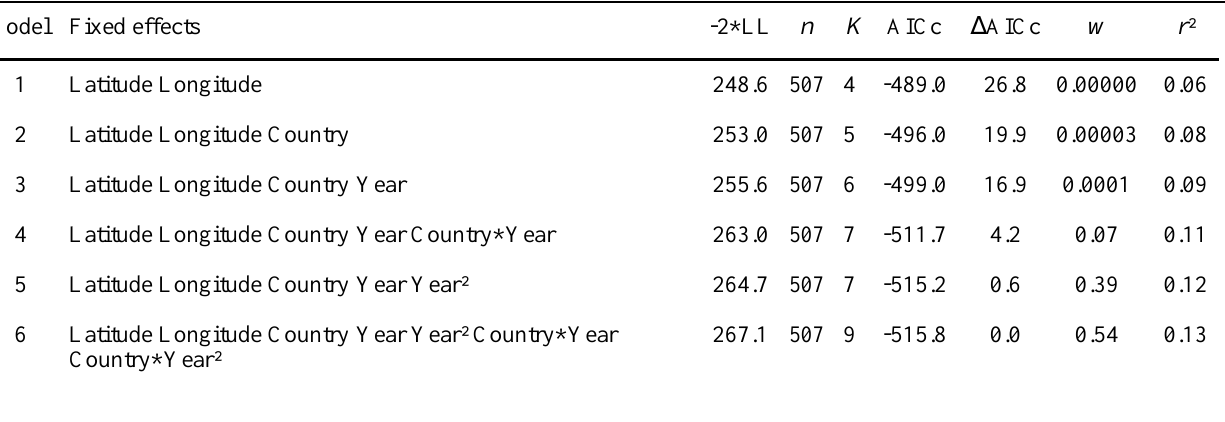
Table 1 . Ranking of six general linear models relating temporal trends in nest success of dabbling ducks as a function of latitude, longitude of study site, country (Canada vs. United States), and year of study between 1935 and 2006. n = sample size; K = number of parameters; AICc = Akaike’s Information Criterion, corrected for small sample sizes; D AICc = the difference in AICc between each model and the model with the minimum AICc; w = Akaike weight; and r ² = the proportion of the total variation in nest success explained by each model (Xu